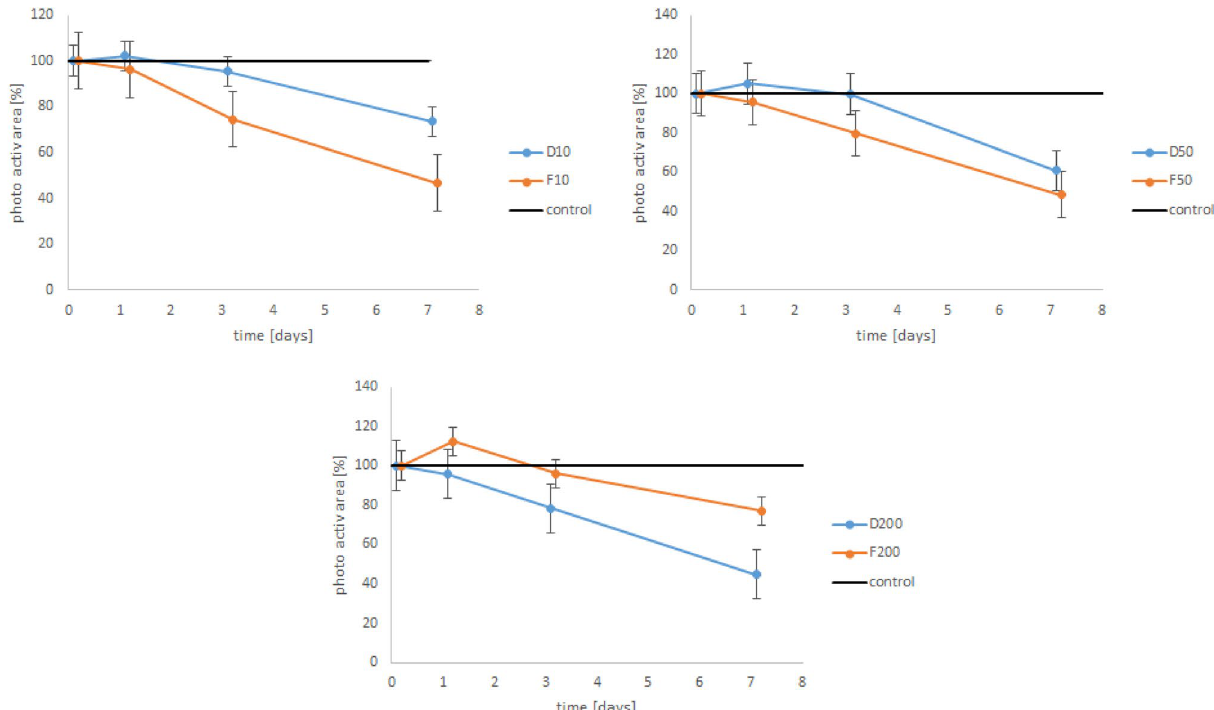
Figure 3. Mean photosynthetic area of the testes foraminifera (six replicates, error bars indicate standard error) with „eco-friendly “ sunscreen compared to the control (black line, where the mean of six replicates relates to 100%). 10, 50 and 200 stand for 10, 50, and 200 mg/L sunscreen, D and F are described in Table